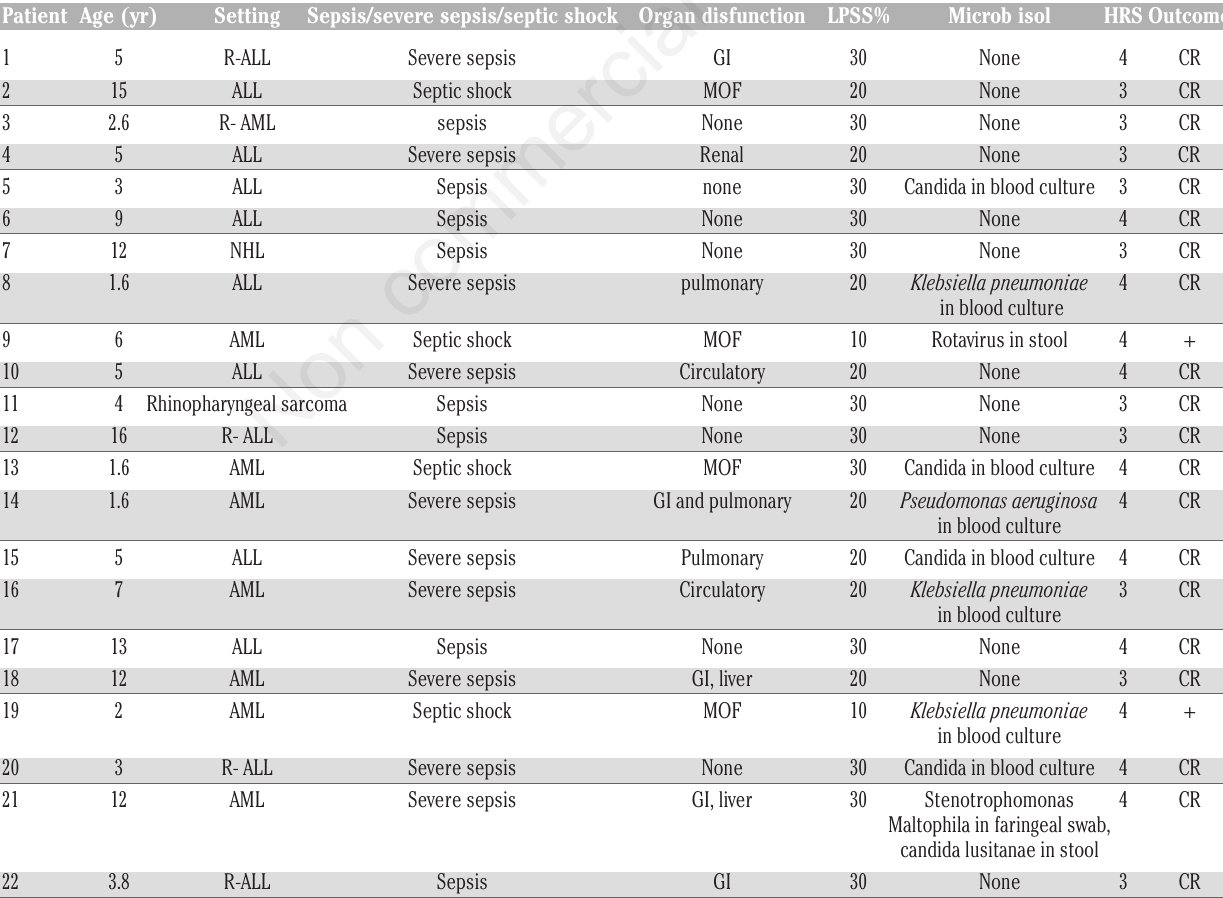
Table 1. Data of the 22 patients of our retrospective study, who received human plasma-derived protein C concentrate from 2008 to 2015 at our Pediatric Hematology/Oncology Center (Bari, Italy). Patient Age